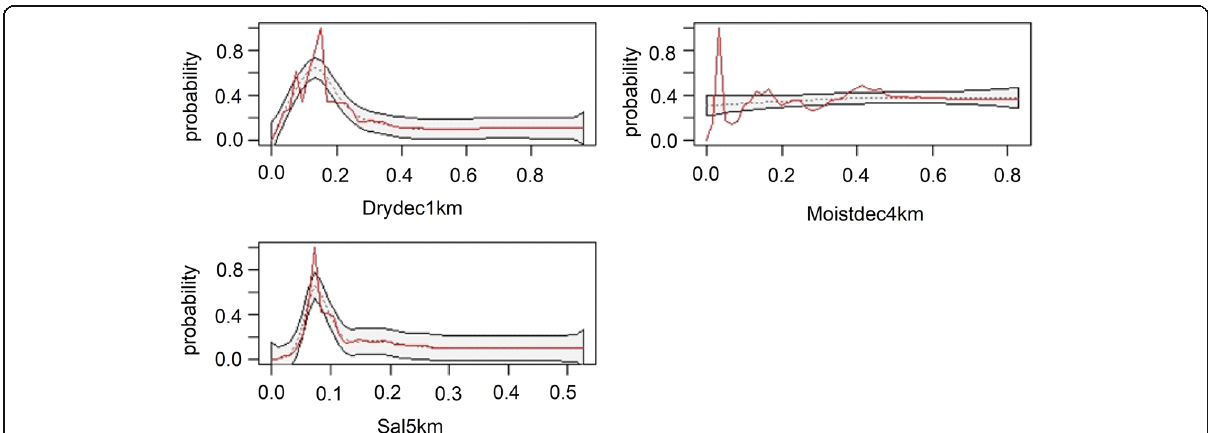
Fig. 6 Partial dependency plots for dry deciduous forests, moist deciduous forests, and sal-dominated forests. The shaded gray region represents 95% confidence intervals, and the red line indicates the average value. The X -axis represents the percentage of the variables ranging from 0 to 1%, and Y -axis represents the predicted probability of the sloth bear